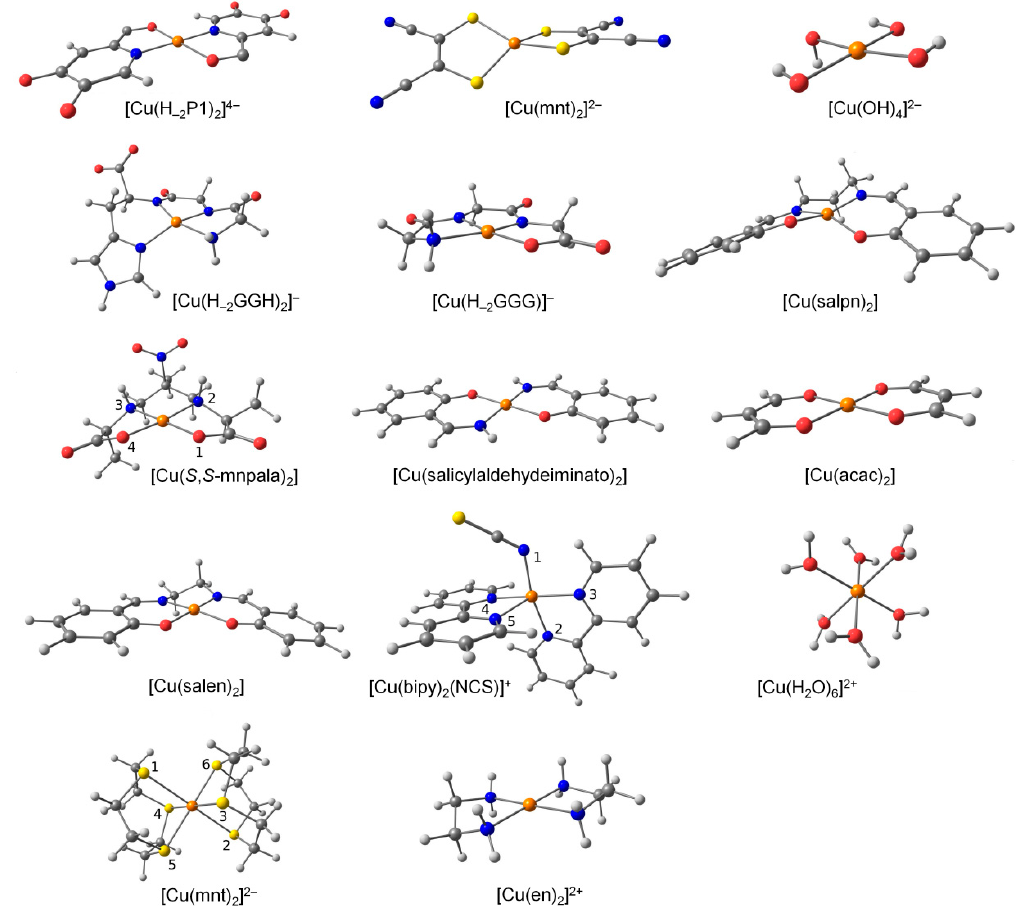
Figure 1. Geometry of the fourteen Cu(II) complexes simulated with B3LYP-D3 functional combined with triple- ζ Pople’s 6-311g(d,p) basis set (main group elements) and Stuttgart–Dresden (SDD) implemented with f -functions and pseudo-potential (Cu). The numbers of the donors reported in Table 1 are also shown.